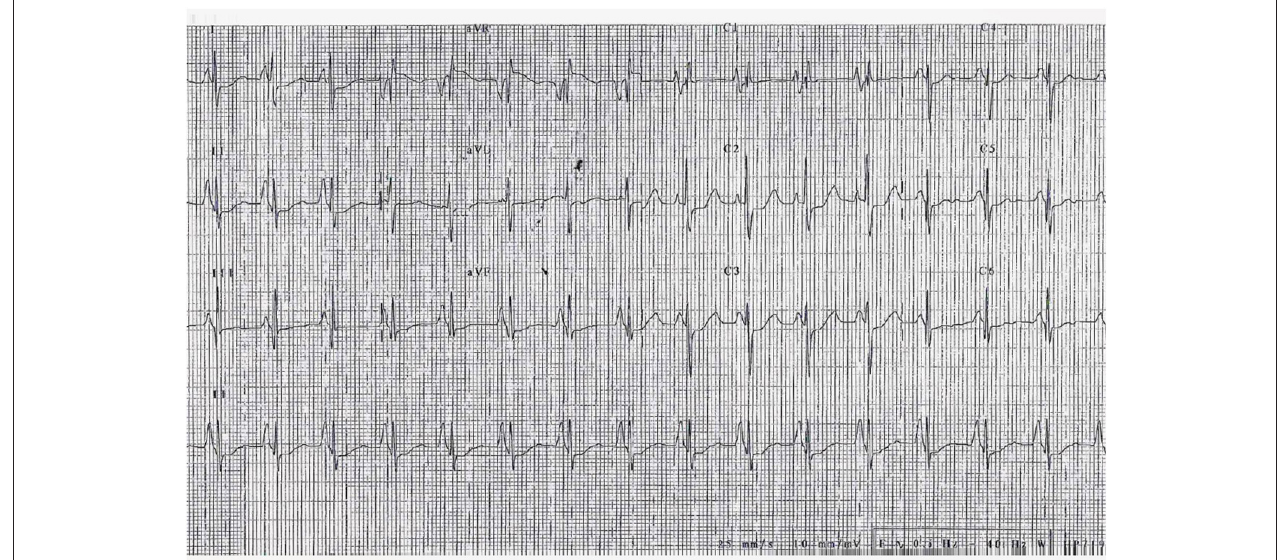
FIGURE 4 | ECG of a 3-year-old girl, affected by restrictive cardiomyopathy, showing biatrial enlargement and diffuse repolarization abnormalities. In the peripheral leads, please note the monstre atrial enlargement.